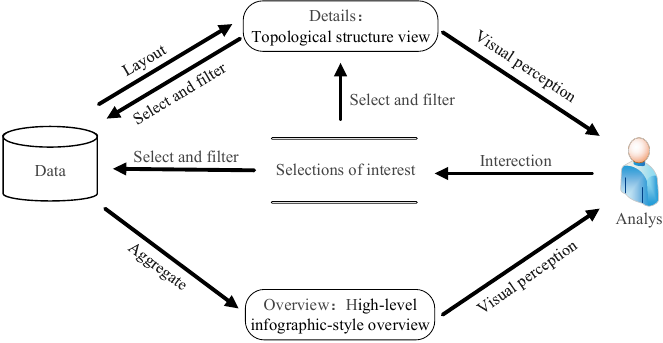
Figure 2. Diagram of analysis model from detail to overview based on selection and aggregation.